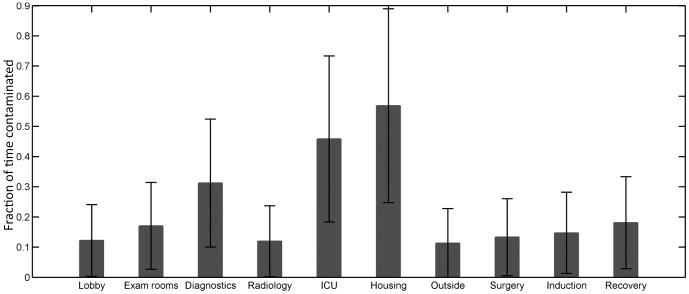
The yearly average of fraction of time that the transmission points remain contaminated.The yearly average of fraction of time each transmission point remains contaminated, averaged further over 500 simulations. Bars represent standard deviation across the yearly averages of 500 simulations.